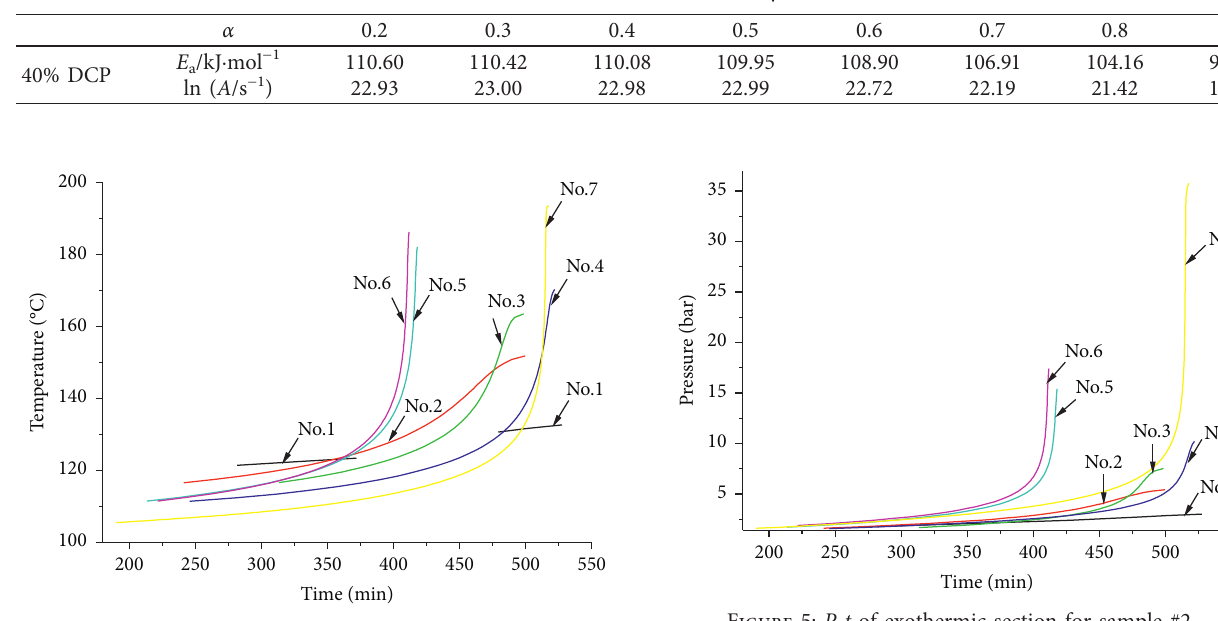
Figure 3: E a ( α ) and ln A ( α ) vs α of sample #2. Table 5: ln A and E a values of 40% DCP obtained by the Friedman method.